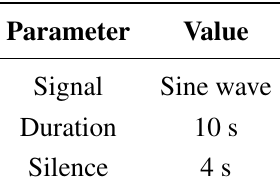
Table 1. Configuration parameters and setup for the narrowband sounding in the 2013 to